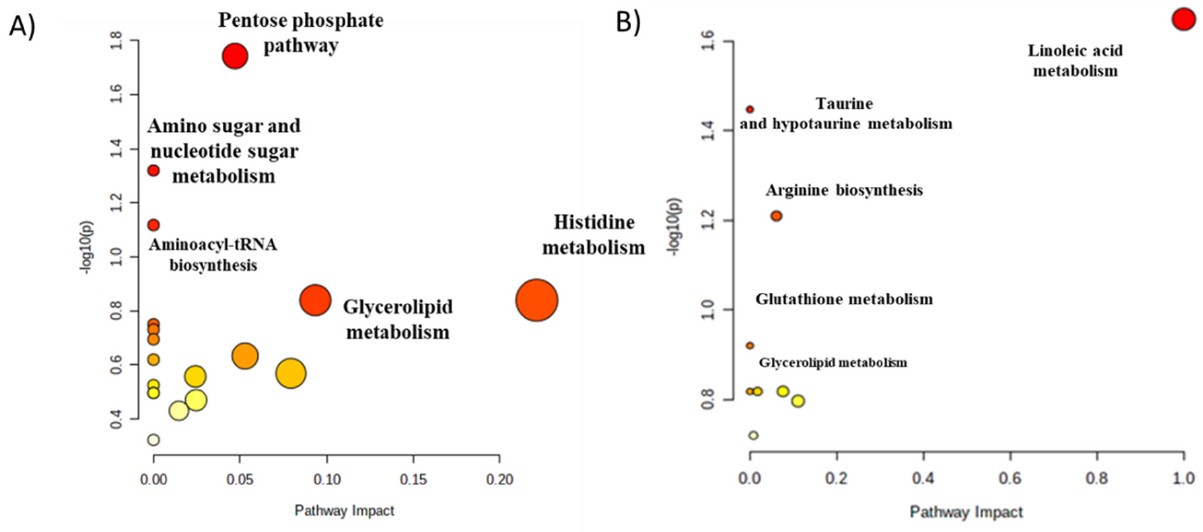
Figure 2. The results of biochemical pathways analysis performed for metabolites detected by GC–MS ( panel A ) and by LC-QTOF-MS ( panel B ). Table 4. Metabolic pathways corresponding to significant metabolites identified in plasma samples with